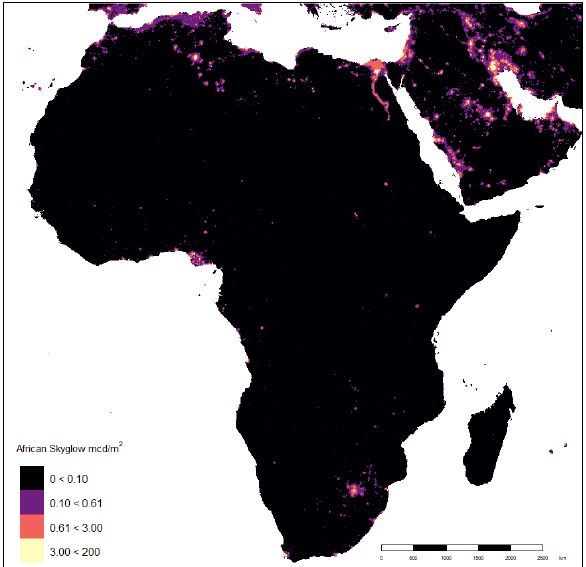
Figure 1. Patterns of skyglow across Africa. The black colour denotes natural night-time illumination levels. The purple colour describes areas in Africa where artificial light at night (ALAN) has polluted the night sky up to the horizon of the landscape but not to the zenith. Areas where skyglow pollution extends to the zenith of the sky are denoted in pink. Lastly, the lightest colour is associated with areas that are polluted to such an extent that no parts of the night sky are visible to human night